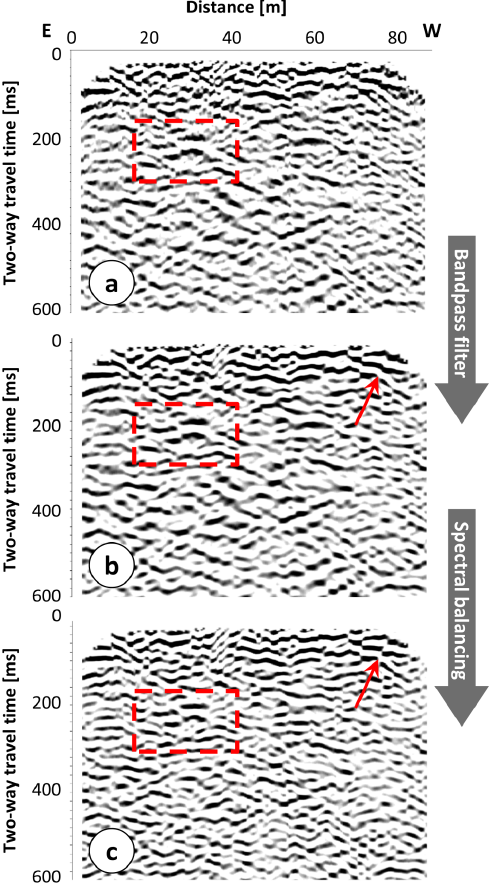
Figure 9. CMP-stacked sections of profile S1 after different pro- cessing steps. (a) The first CMP-stacked section shows residual noise. (b) After applying a bandpass filter to the stacked data the reflectors have an improved S/N ratio, especially from 0 to 400ms TWT. (c) By using spectral balancing the lateral resolution is fur- ther improved (note red boxes and arrows showing the improved resolution of near-surface